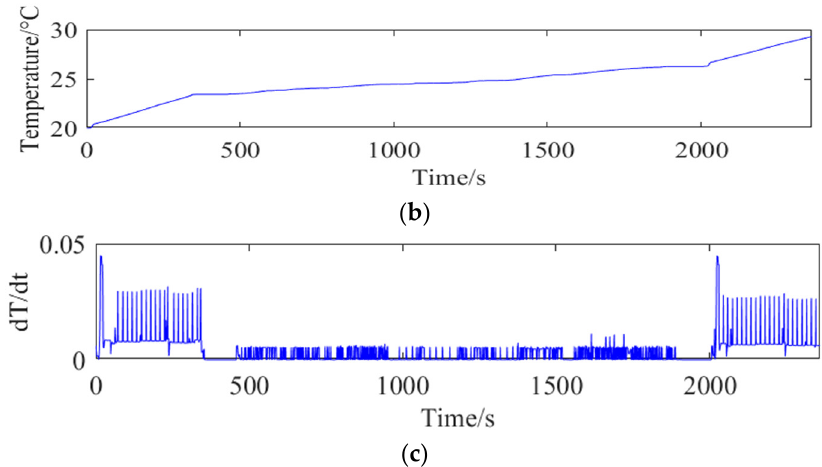
Figure 12. Validation of the PMP-MPC strategy under the air-ground driving cycle A. ( a ) The blue line represents the engine-generator set power; the red line represents the battery power; the green line represents the demand power. ( b ) Battery temperature profiles. ( c ) Battery temperature change rate per instant.